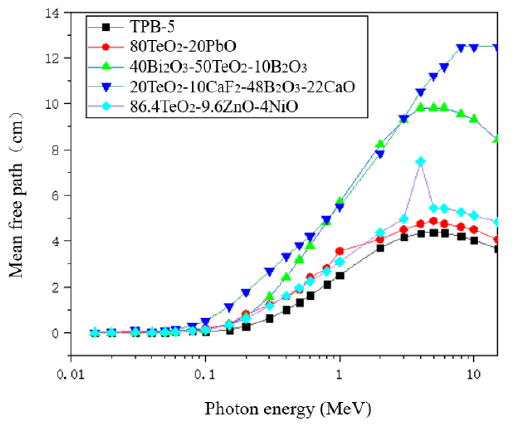
8 of 11 Figure 5. Half value layer (HVL) of TPB glass system under different photon energy and chemical composition. In addition, we also investigated the mean free path MFP of the TPB series of glasses. The theoretically calculated MFP values of TPB-5 glass are compared with those of other radiation shielding glass materials, as shown in Figure 6. Similar to HVL, the smaller the MFP value, the better. As the value of MFP decreases, the distance between two successive interactions is smaller, which means that the attenuation ability of materials of equal thick- ness is more significant. Therefore, the MFP value can directly represent the performance